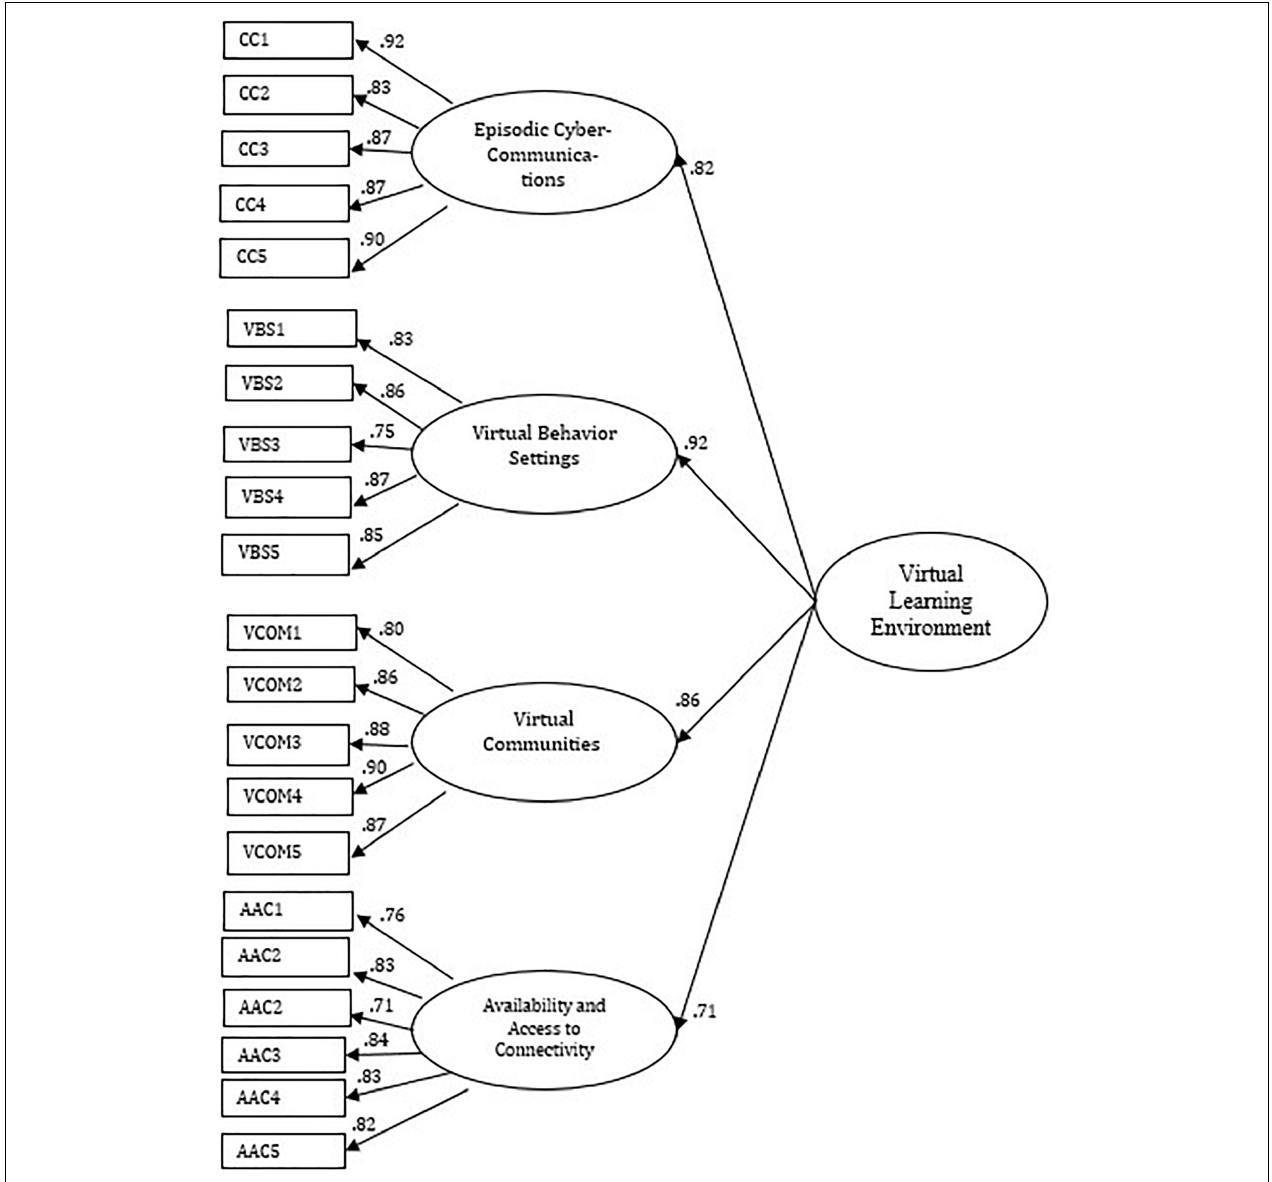
FIGURE 2 | Structural equation model of second-order factor virtual learning environment with four first-order factors. All factor loadings are significant ( p < 0.05). Values of errors are not reported. Goodness of fit: χ 2 = 668.04 ( df = 179), p = 0.000; BBNFI = 0.92, BBNNFI = 0.93, CFI = 0.94; RMSEA = 0.08. Circles indicate latent variables, and boxes indicate the number of the